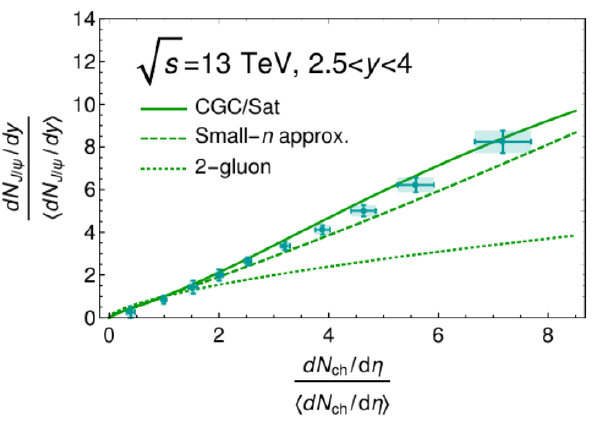
Figure 25. Multiplicity dependence of J / ψ in √ 13 center of mass energies pp collisions at the ALICE experiment. Left figure corresponds to ALICE data in the forward region [178,181]. Theory comparisons from the work in